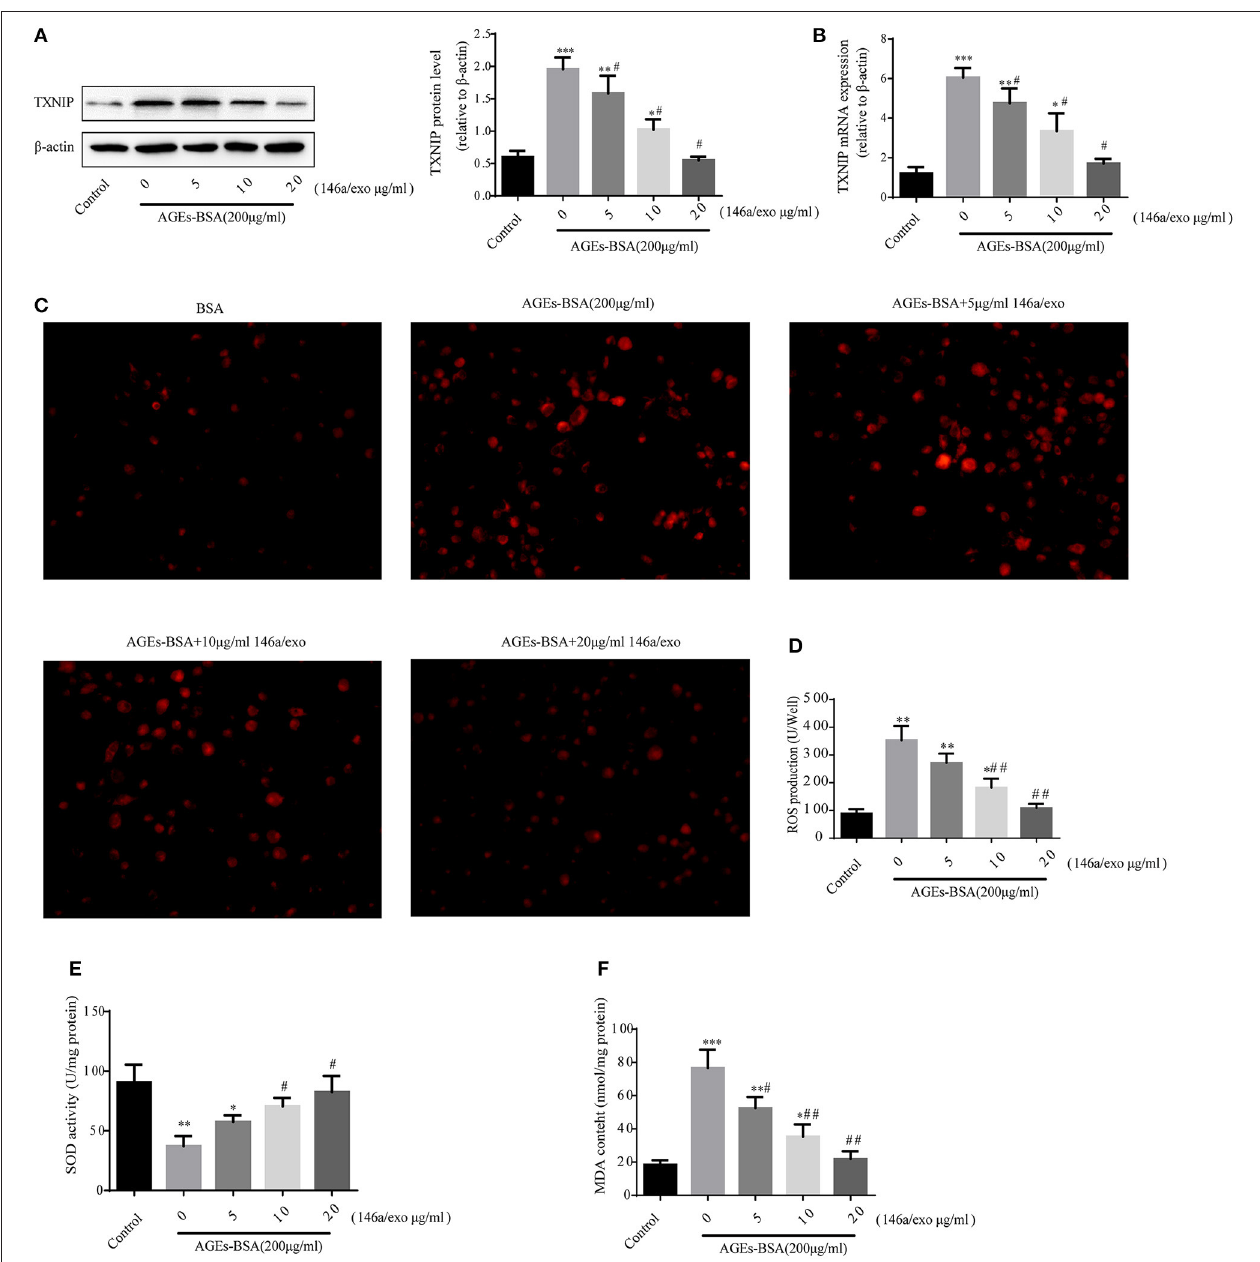
FIGURE 9 | Effects of miR-146a/exo on AGEs-BSA–induced TXNIP expression and ROS production in VSMCs. (A,B) TXNIP mRNA and protein levels by Western blotting and qPCR. (C) ROS concentrations and fluorescence micrographs of ROS levels. (E) ROS production. (F) SOD activity. (G) MDA content. * p < 0.05, ** p < 0.01, and *** p < 0.001 vs. the control group; # p < 0.05 and ## p < 0.01 vs. AGEs-BSA